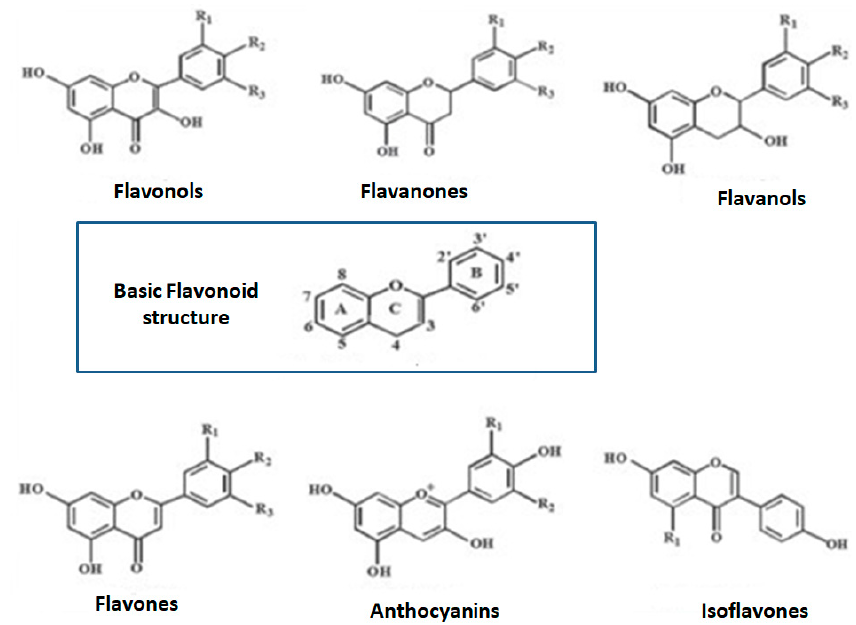
Figure 2. Chemical structures of sub-classes of flavonoids. Adapted from Guasch-Ferré M 2017 [1].